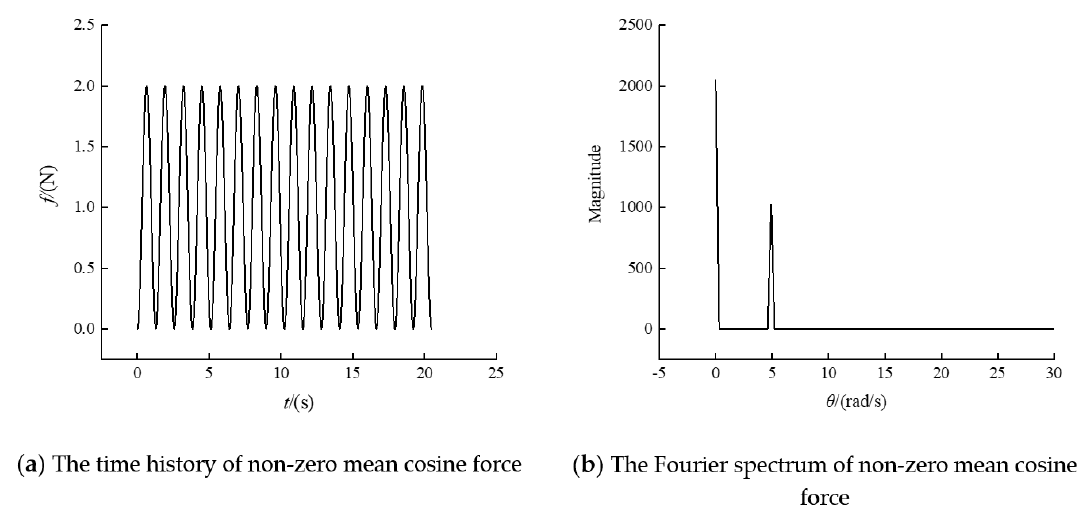
Figure 4. The acceleration time history and Fourier spectrum of non-zero mean harmonic force.